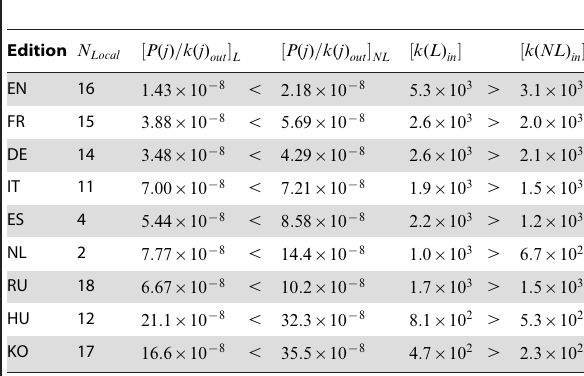
Table 3. PageRank contribution per link and in-degree of PageRank local and non-local heroes i for each edition.